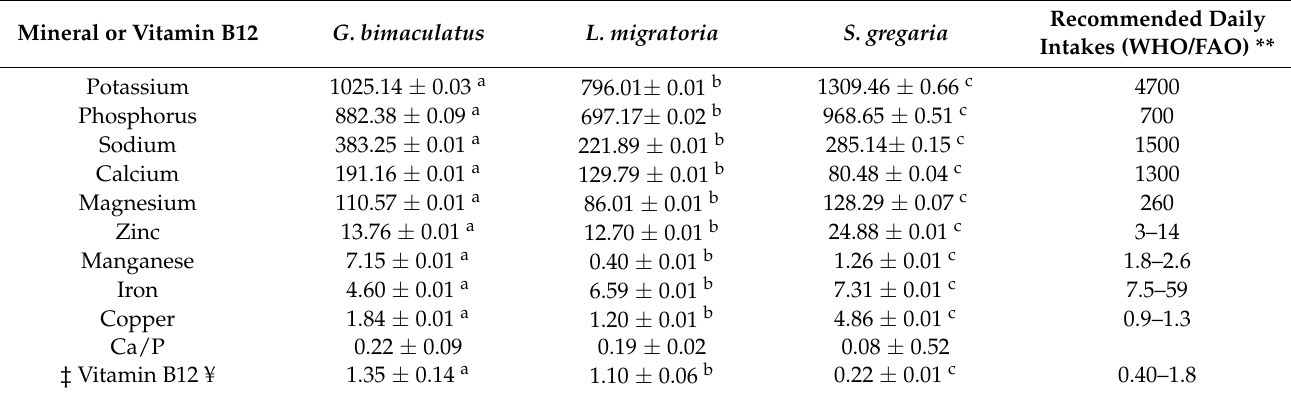
Table 5. Recommended daily intakes, mineral content (mg/100 g dry matter), and vitamin B12 content ( µ g/100 g dry matter) of G. bimaculatus , L. migratoria , and S. gregaria : each value represents the mean ± standard deviation of triplicate